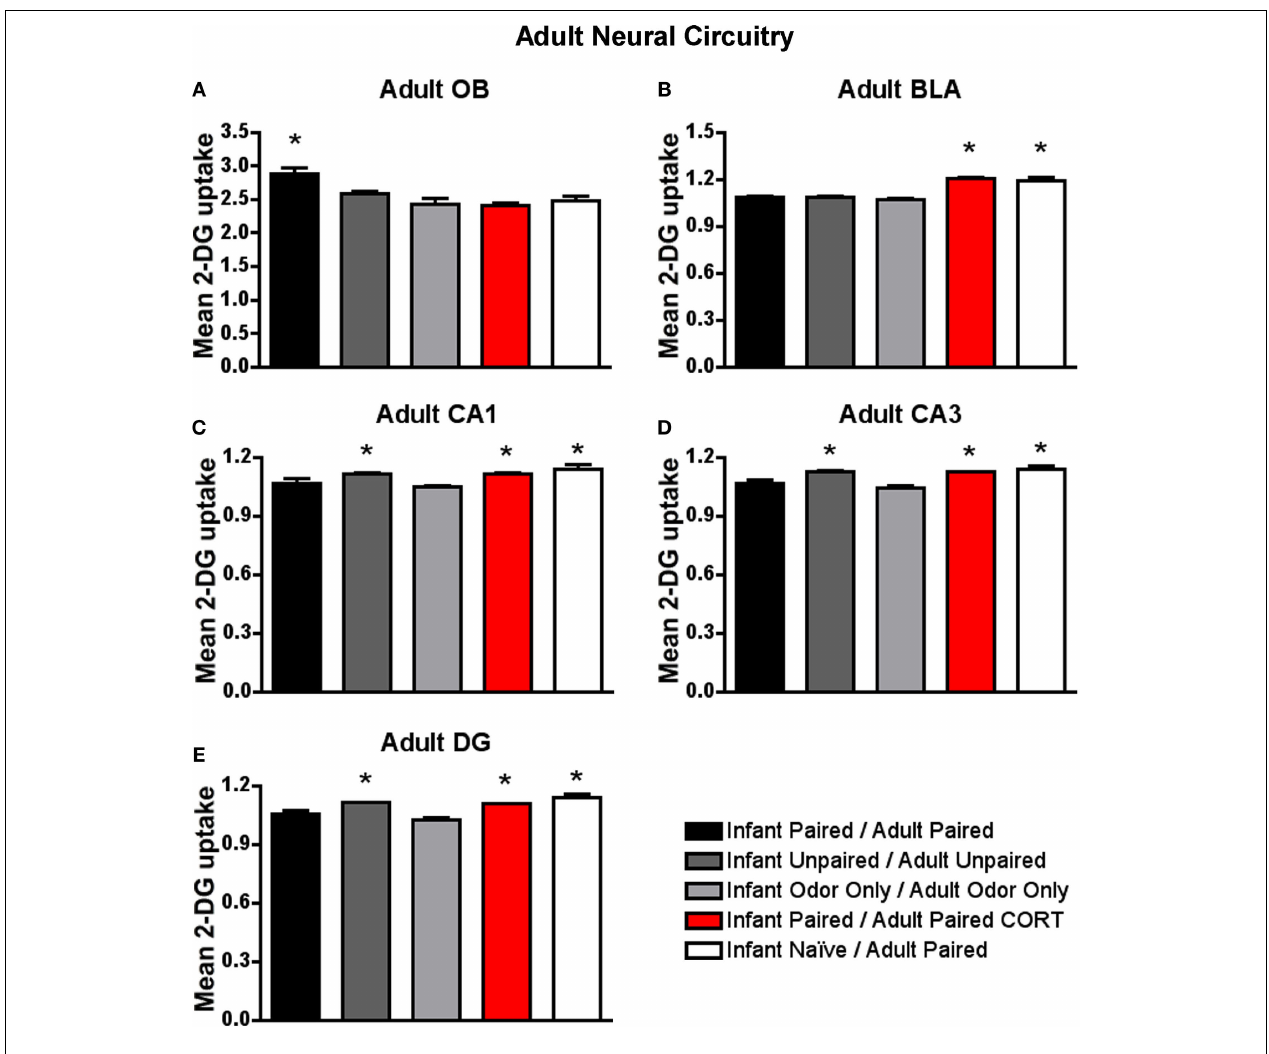
FIGURE 9 | Adult rats were reconditioned after the infant conditioning, generally using the same conditioning group in infancy and adulthood. 14 C 2-DG autoradiography during the adult odor-shock conditioning session showed that (A) Infant Paired/Adult Paired animals exhibit activation in the odor- specifi c loci of the olfactory bulb (OB) compared to Infant Paired/Adult Paired CORT injection and Infant Naïve/Adult Paired, (B) Infant Naïve/Adult Paired and